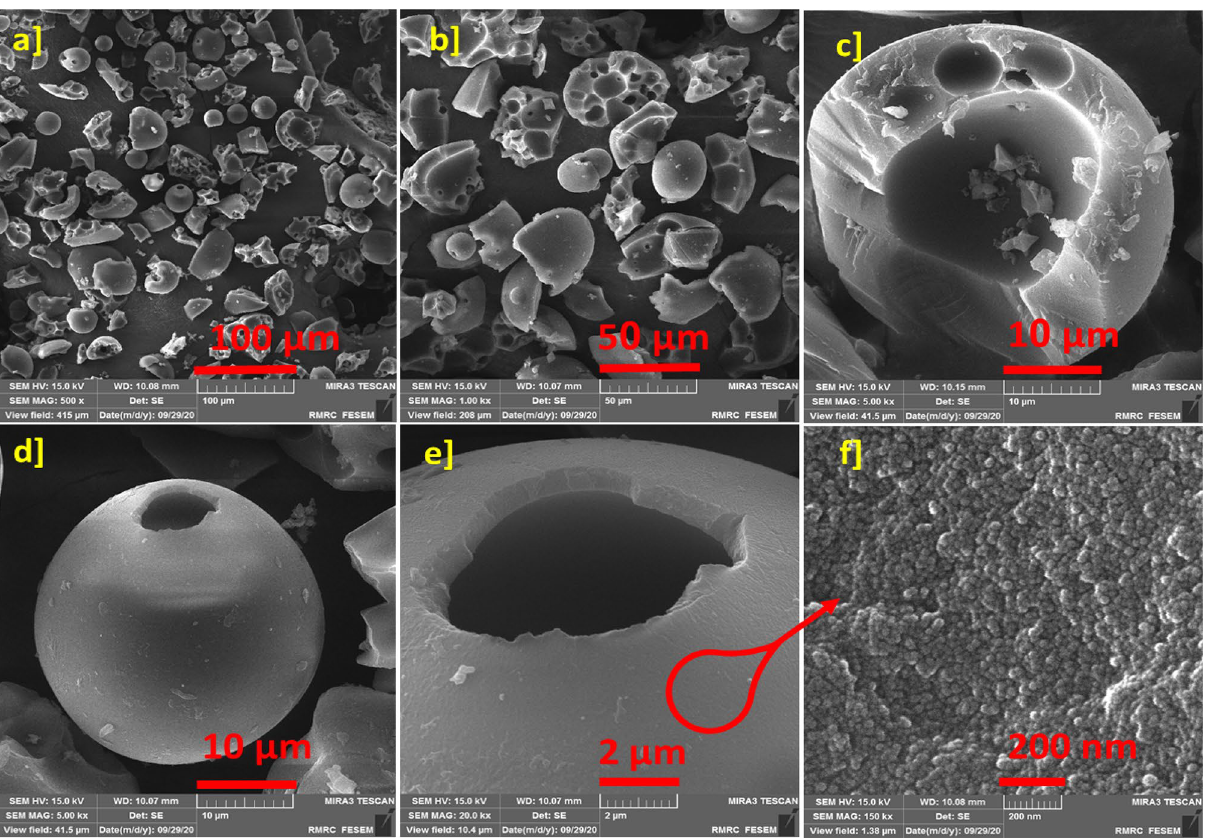
Figure 6. The FE-SEM images ZnTPP /Cu-NPs-PAA (1) ( a – f ) represent the porous spherical morphology from the route using